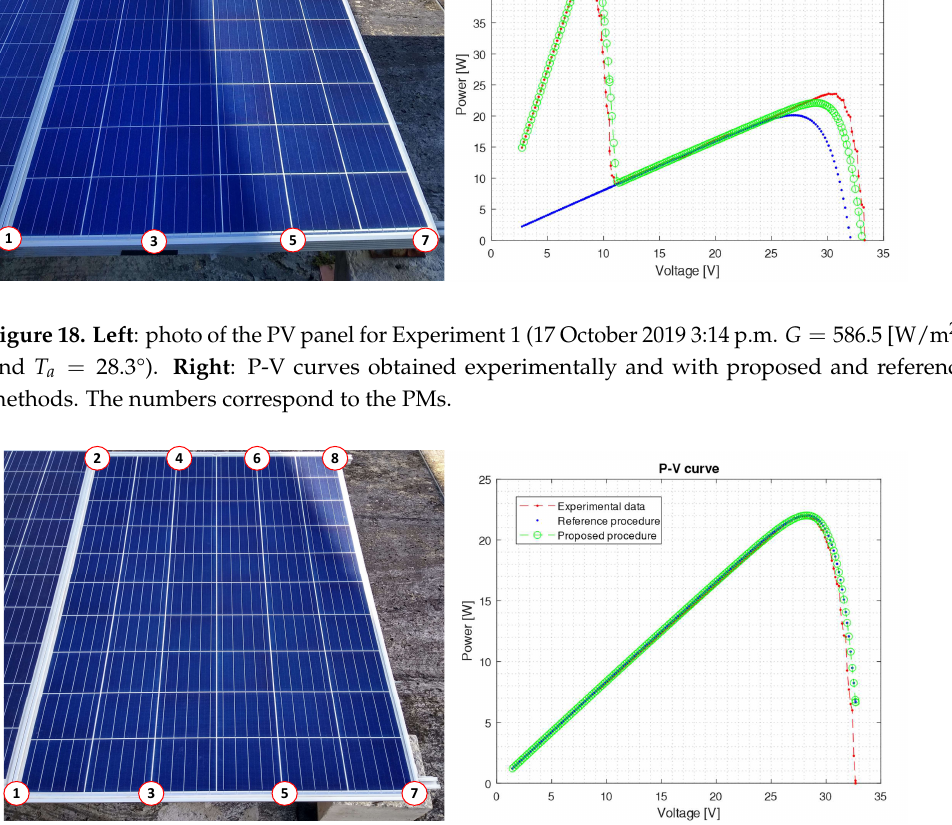
Figure 19. Left : photo of the PV panel for Experiment 2 (17 October 2019 3:37 p.m. G = 114 [W/m 2 ], and T a = 29.3°). Right : P-V curves obtained experimentally and with proposed and reference methods. The numbers correspond to the